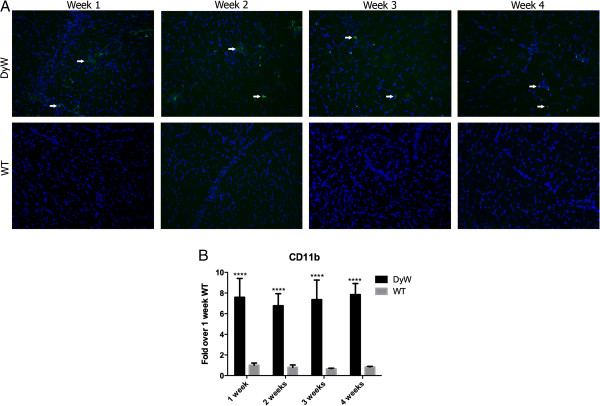
Mac-1 staining and quantitative RT-PCR of CD11b show elevated macrophage infiltration throughout postnatal development. (A) Mac-1 immunostaining of tibialis anterior muscle sections shows high macrophage infiltration as early as postnatal week 1 in Lama2DyW (DyW) mice. Wild-type (WT) mice had minimal macrophage presence at weeks 1 and 2 and virtually none by weeks 3 and 4. (B) Confirmation of these results by CD11b quantitative RT-PCR shows consistent seven- to elevenfold increases in expression compared to age-matched WT (P < 0.0001 by two-way analysis of variance for all groups (n = 5 for all groups)). Asterisks indicate statistical significance between age-matched DyW and WT animals, hash tags indicate significant changes within the DyW group and Delta indicate significant changes within the WT group. *P < 0.05, **P < 0.01, ***P < 0.001 and ****P < 0.0001. These statistical representations also apply other symbols (Δ, #). Bar =100 μm.